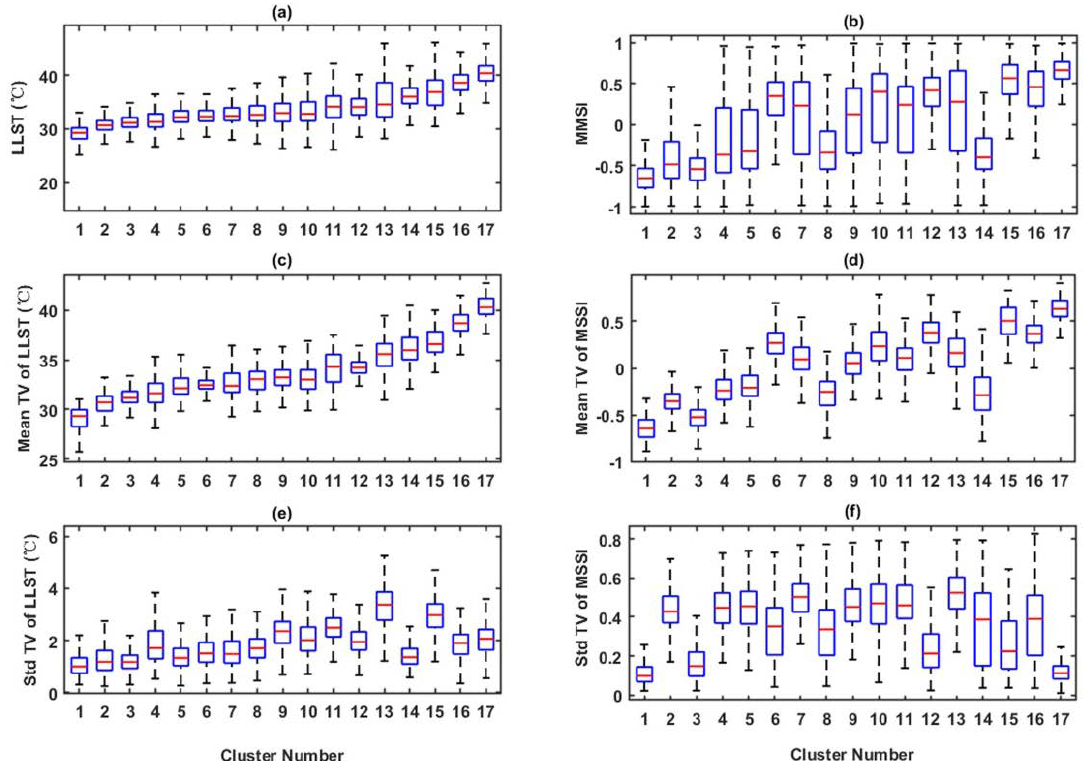
Figure 14. The boxplots of the time series clustering results. The whole boxplot of ( a ) LLSTs; ( b ) MSSIs; The temporal variance (TV) boxplot of ( c ) the mean LLSTs of each time series; ( d ) the mean MSSIs of each time series; ( e ) the standard deviations (Std) of LLSTs of each time series; ( f ) the Std of MSSIs of each time series.